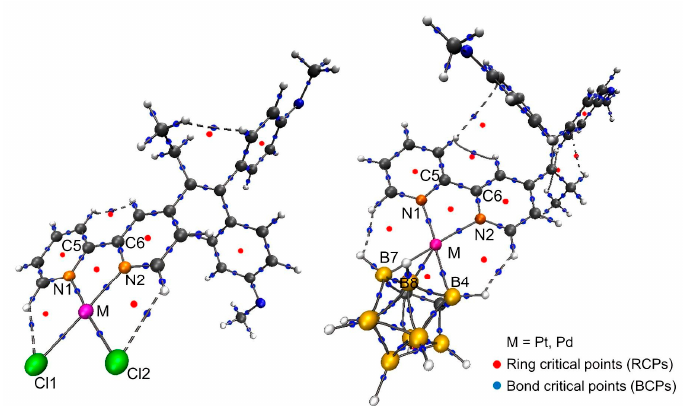
Figure 2. QTAIM analysis: molecular graphs of metal(II) dichlorido complexes ( 5 and 6 , left ) and the metallacarboranes ( 7 and 8 , right ). The bond paths of the non-covalent interactions are shown as dashed lines. The bond critical points (BCPs) and the ring critical points (RCPs) are indicated as blue or red dots.